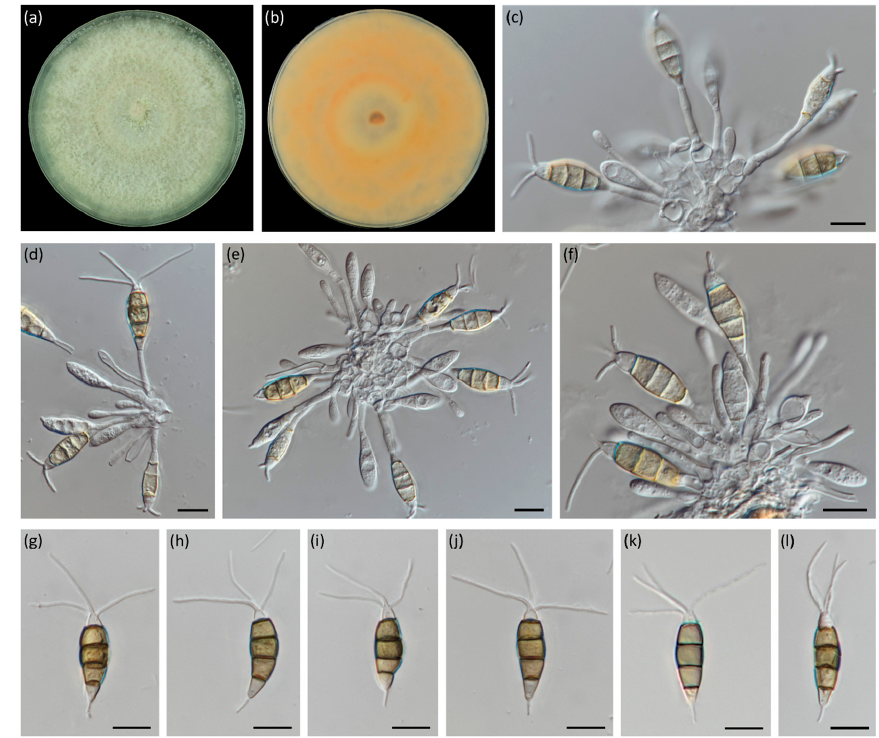
Figure 2. Pestalotiopsis pini (MEAN 1094). ( a,b ) Colony on PDA after 10 days at 23 ± 2 °C—surface view and reverse, respectively. ( c – f ) Conidiophores, conidiogenous cells and attached conidia. ( g – l ) Conidia. Scale bars: 10 μ m.